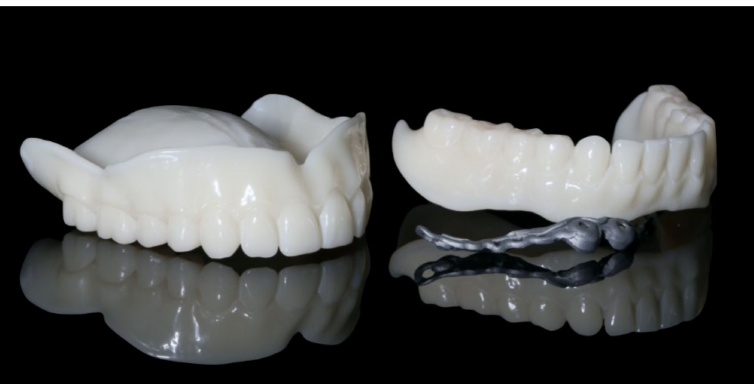
Figure 10. Additively manufactured try-in dentures for the upper and lower jaw and selectively laser sintered (SLS) alloy framework.